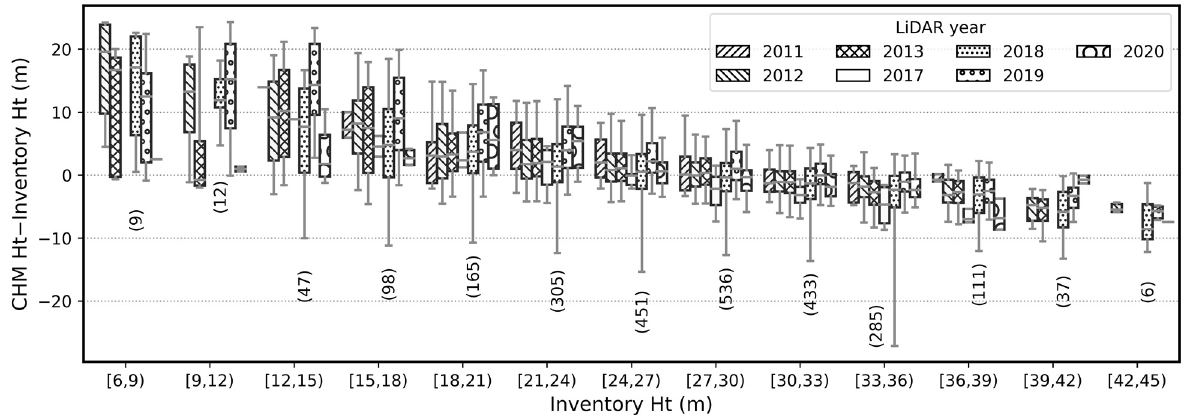
Figure 12. Height measurement error in relation to LiDAR point density and acquisition year. Data with LiDAR density less than 10 points/m 2 were displayed. Boundaries of upper and lower whisker is the ninety-seventh and third percentiles. The number above each box plot is median, and the number below box plot is number of data points. CHM: canopy height model; Ht: height.